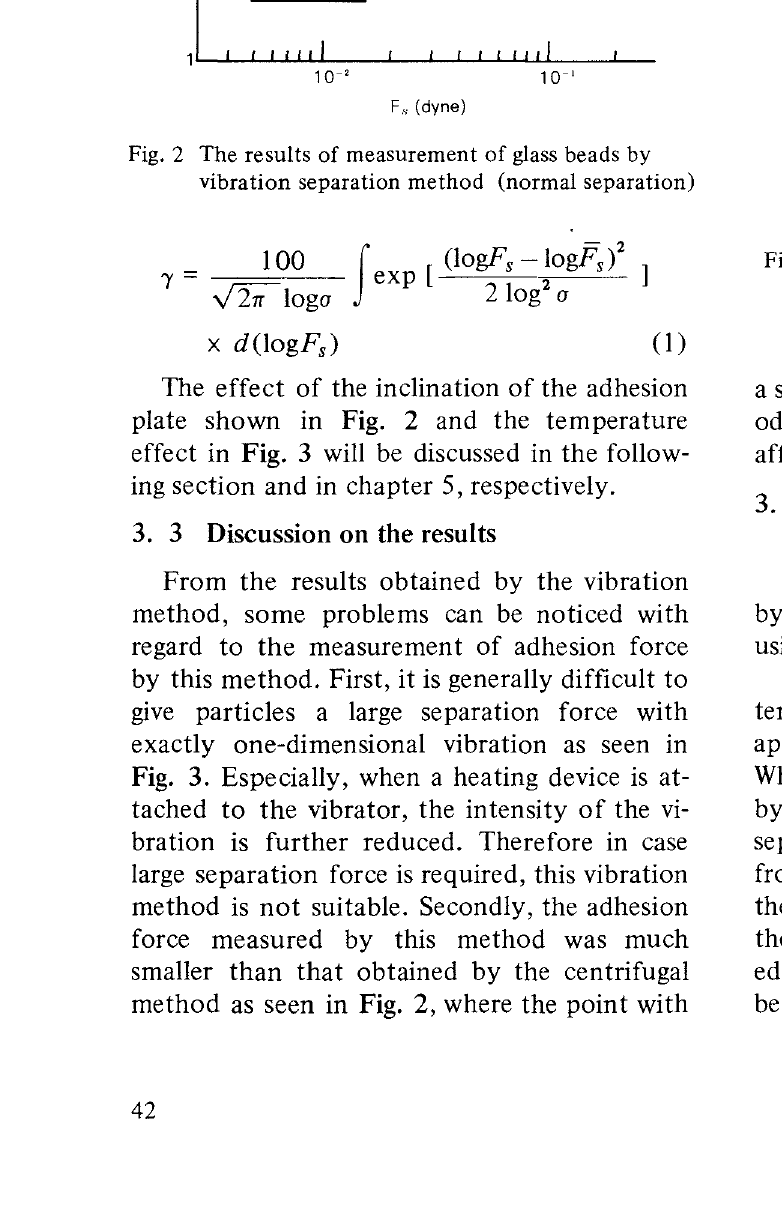
Fig. 2 The results of measurement of glass beads by vibration separation method (normal separation)